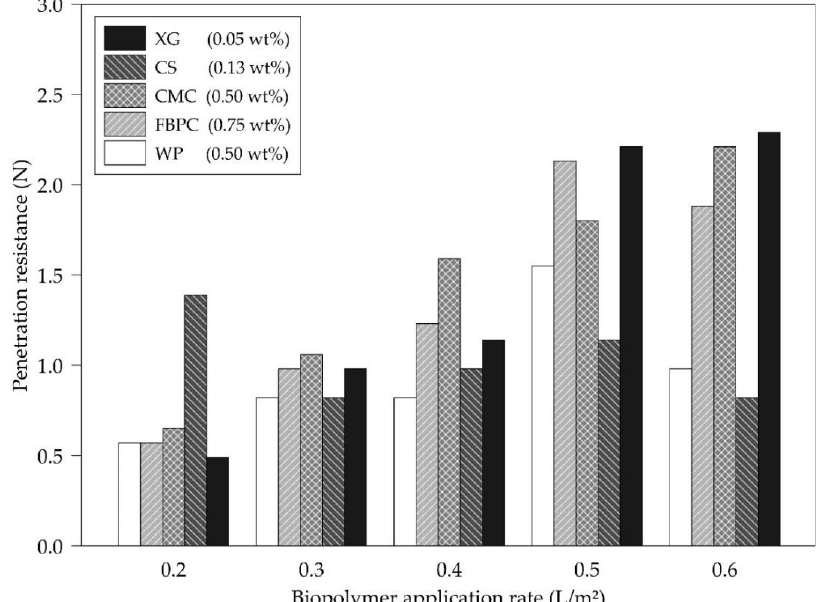
Figure 10. Penetration resistance of crusts from medium-grained sand samples, performed after the fifth wind tunnel cycle on day 28. Biopolymers were applied at their respective plateau concentration determined in Phase 1. Each of the three prepared samples was penetrated at the top and bottom of the centre (n = 6). The numerical results are appended in Table A5.